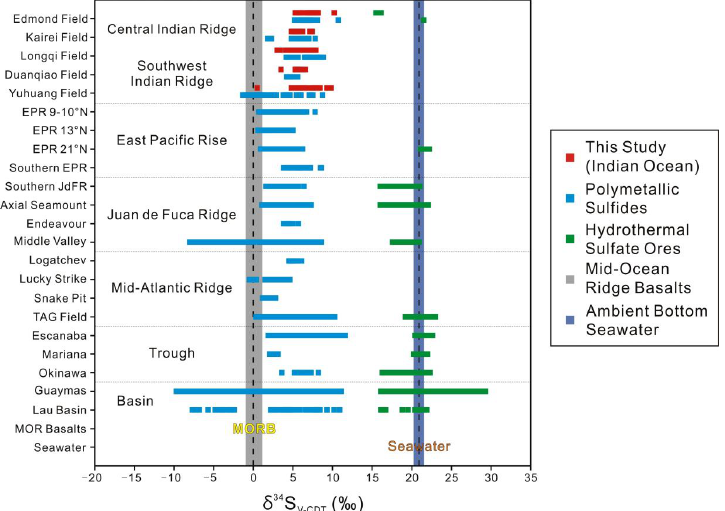
Figure 5. Figure 5. A comparison of variations in sulphur isotopic compositions of different